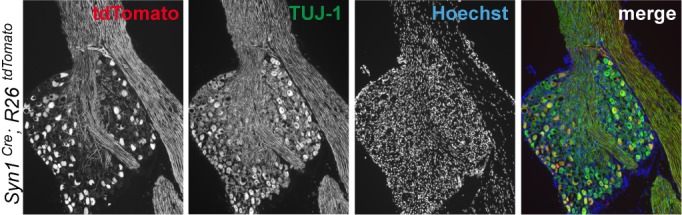
Immunohistochemistry of DRG cryosections from Syn1-Cre;R26LSL.tdTomato mice exhibits labeling of axons from medium- and large-diameter TUJ1-positive sensory neurons.